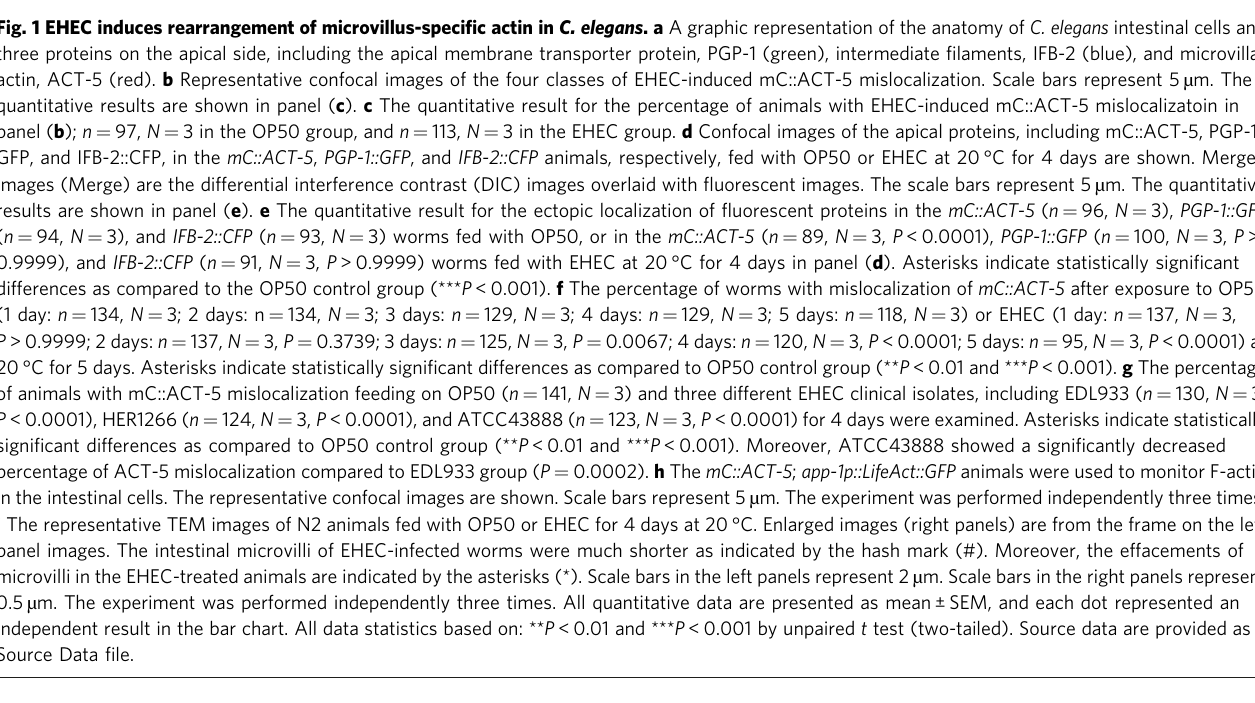
percentage of ACT-5 mislocalization compared to EDL933 group ( P = 0.0002). h The mC::ACT-5 ; app-1p::LifeAct::GFP animals were used to monitor F-actin in the intestinal cells. The representative confocal images are shown. Scale bars represent 5 µ m. The experiment was performed independently three times. i The representative TEM images of N2 animals fed with OP50 or EHEC for 4 days at 20 °C. Enlarged images (right panels) are from the frame on the left panel images. The intestinal microvilli of EHEC-infected worms were much shorter as indicated by the hash mark (#). Moreover, the effacements of microvilli in the EHEC-treated animals are indicated by the asterisks (*). Scale bars in the left panels represent 2 µ m. Scale bars in the right panels represent 0.5 µ m. The experiment was performed independently three times. All quantitative data are presented as mean ± SEM, and each dot represented an independent result in the bar chart. All data statistics based on: ** P < 0.01 and *** P < 0.001 by unpaired t test (two-tailed). Source data are provided as a Source Data fi